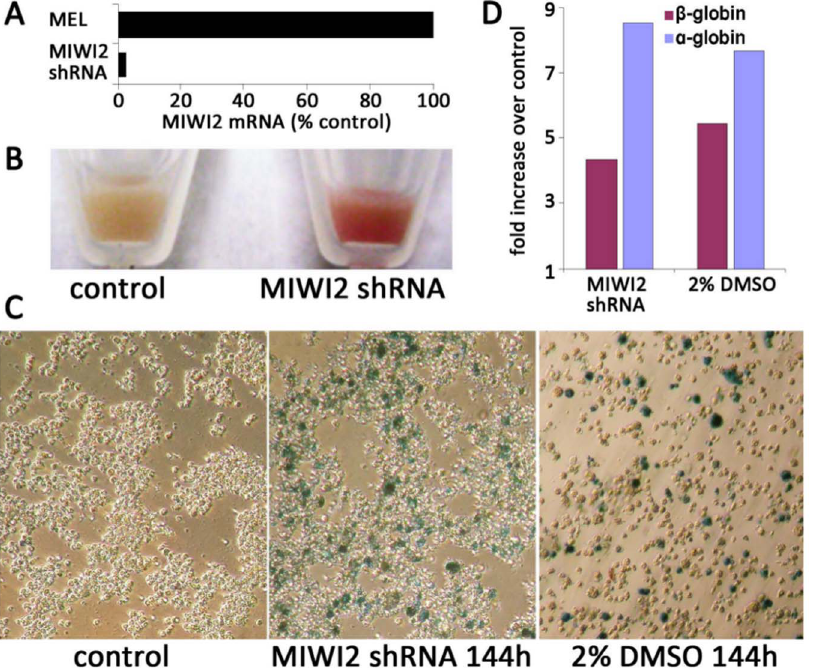
Figure 2. Knockdown of MIWI2 mRNA by RNAi induces differentiation of MEL cells. [A] 48 h after infection of MEL cells with a lentiviral vector expressing a shRNA specific for MIWI2, the level of MIWI2 mRNA is sharply lower. [B] Pelleted control MEL cells (left) and MEL cells 144 h post infection with the MIWI2-specific shRNA lentiviral vector (right). The distinctly red color of the cells at right indicates erythroid differentiation with hemoglobin expression. [C] Benzidine stained control MEL cells (left), MIWI2 shRNA knockdown cells 144 h after infection (center), and MEL cells induced with DMSO for 144 h (right). Following staining with benzidine cells that express hemoglobin appear blue. [D] Expression of a -globin (Hg a ) and ßmaj-globin (Hg b ) mRNA in MEL cells 144 h after beginning knockdown of MIWI2 (top), or 144 h after beginning induction of terminal differentiation with 2% DMSO (bottom). mRNA expression was measured by quantitative RT-PCR; levels are expressed relative to untreated MEL cells, normalized to GAPDH control.